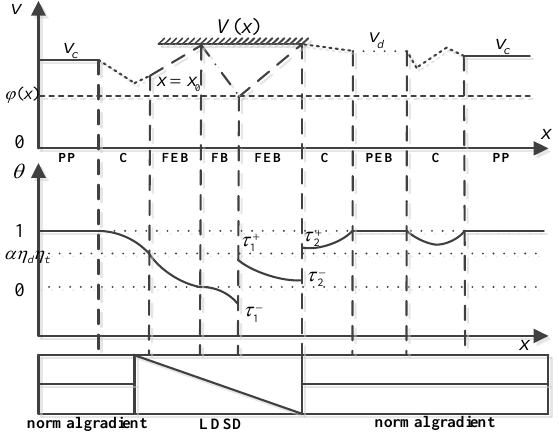
Figure 10. Linkage of the speed holding section considering the LDSD section ( v c < V ( x ) ).